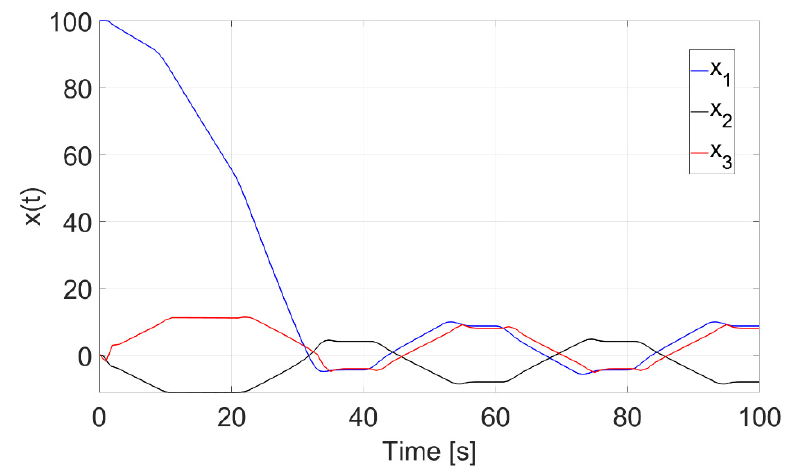
Figure 6. States of the plant controlled by the non-switching controller.